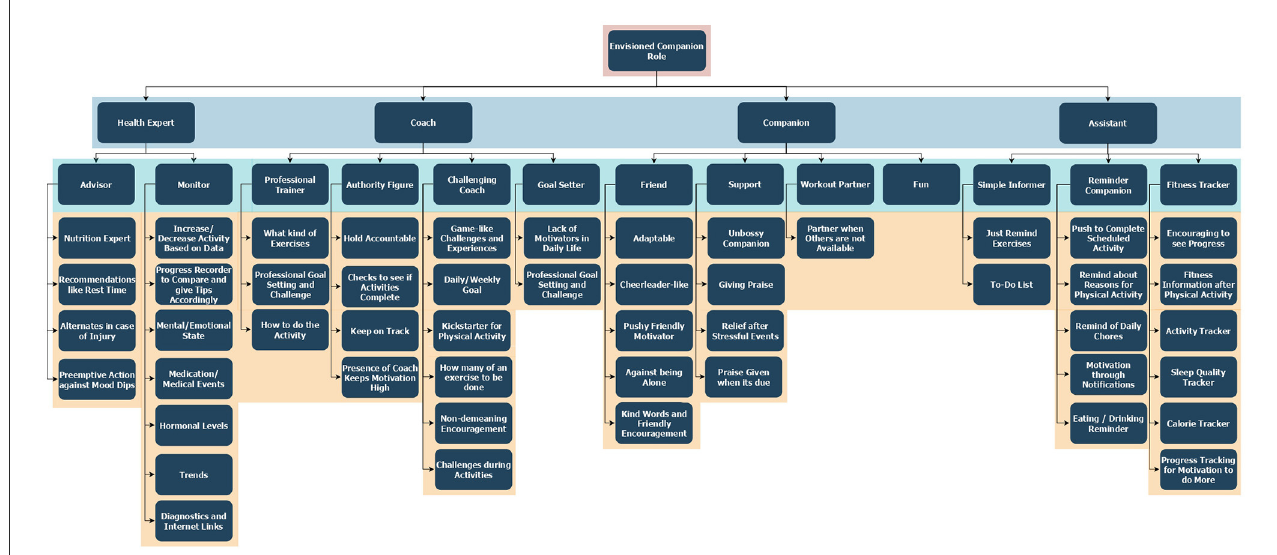
FIGURE4 Resulting themes based on study 2 participants’ views on the agent’s behavior and roles. The blue layer outlines the envisioned companion roles participants have described, whereas the turquoise layer describes the sub-roles the companion can play. The orange layer describes reasons for choosing a sub-role or actions participants would want a companion to execute.